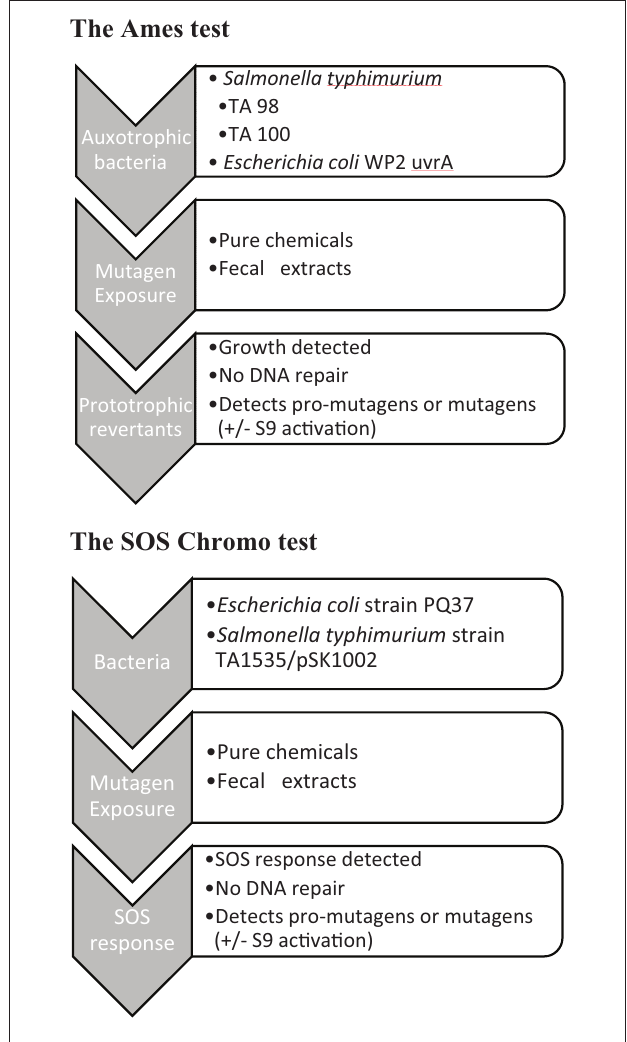
Figure 1 | Schematic illustration of the bacterial mutation assays [(A) Ames test and (B) SOS Chromo